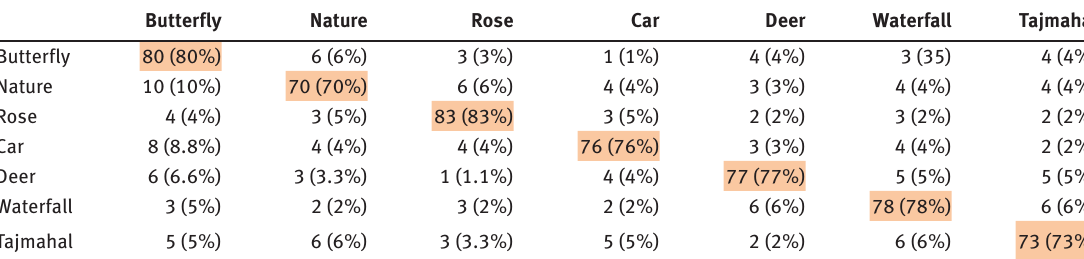
Table 1: Confusion Matrix for Theorem 1.